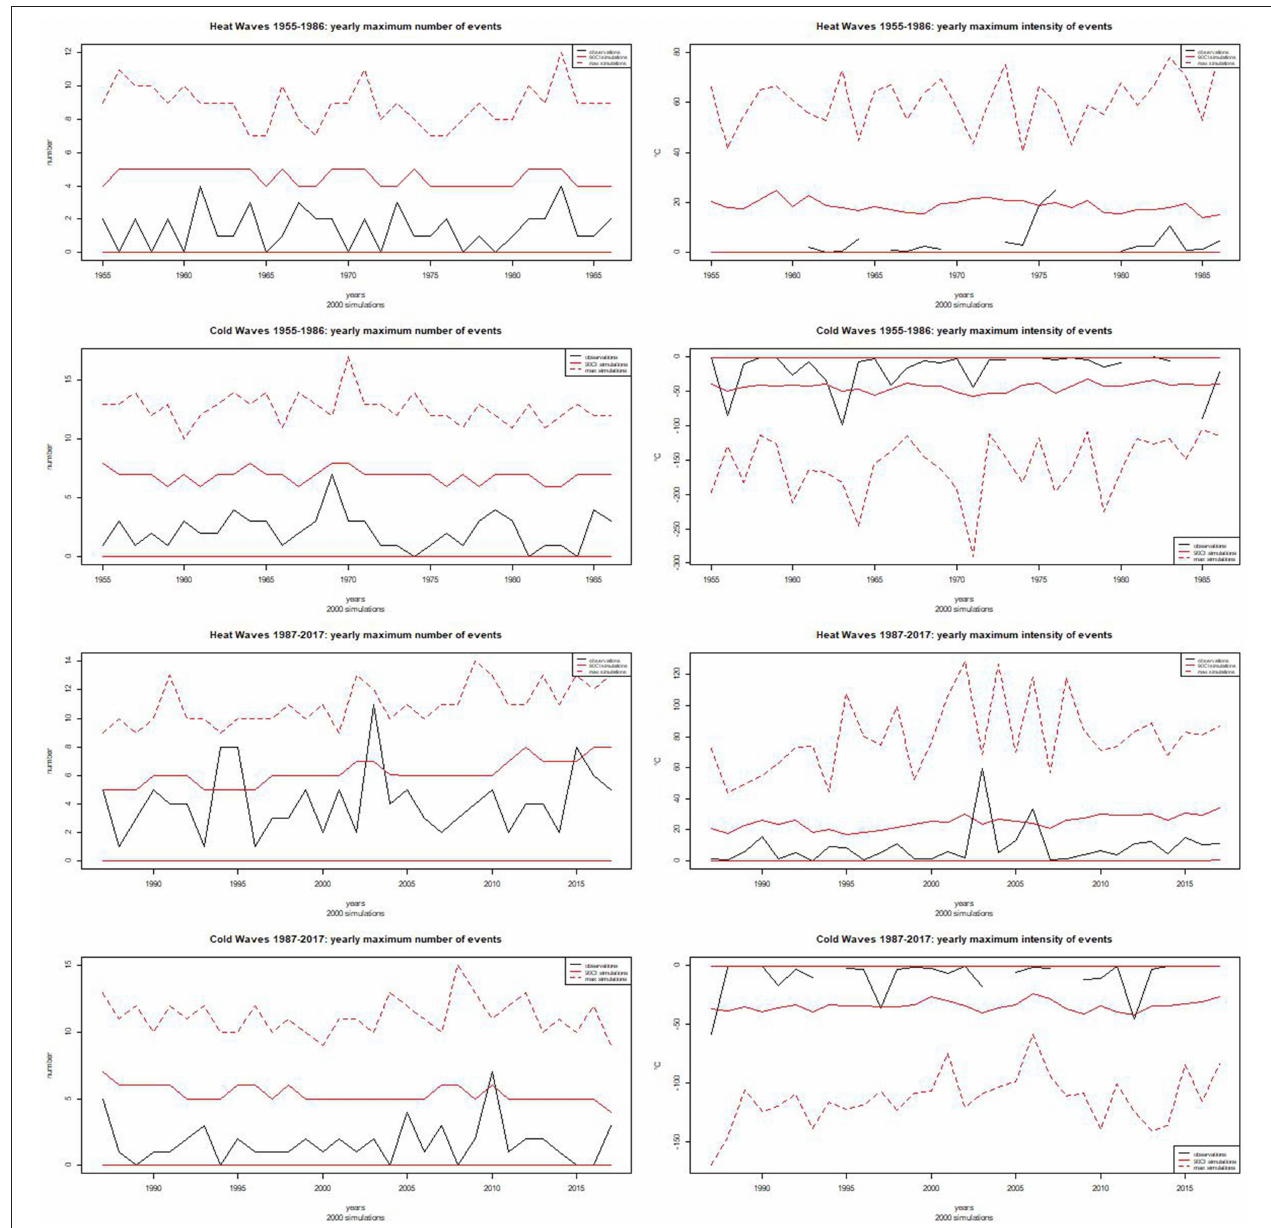
FIGURE 6 | Yearly maximum number of events (left panels) and yearly maximum intensity of the events (right panels) for heat waves and cold waves in 1955-1986 (first two lines) and in 1987–2017 (last two lines). In all figures, the black lines are for the observations, the red lines correspond to the 90% Confidence Interval from the reconstructed trajectories and the dotted red line illustrates the maximum obtained from the reconstructed